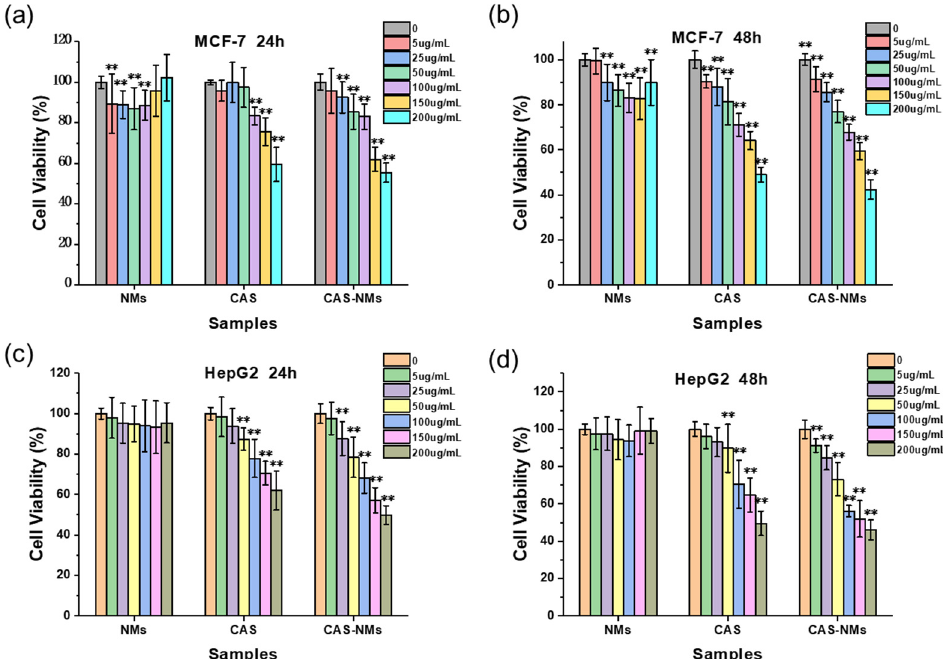
Figure 4. Cell viability of MCF-7 ( a , b ) and HepG2 ( c , d ) incubated with blank nanoemulsions (NMs), free casticin (CAS), and CAS-loaded nanoemulsions (CAS-NMs) for 24 h and 48 h respectively, which ** means p < 0.01 as compared to the control group.